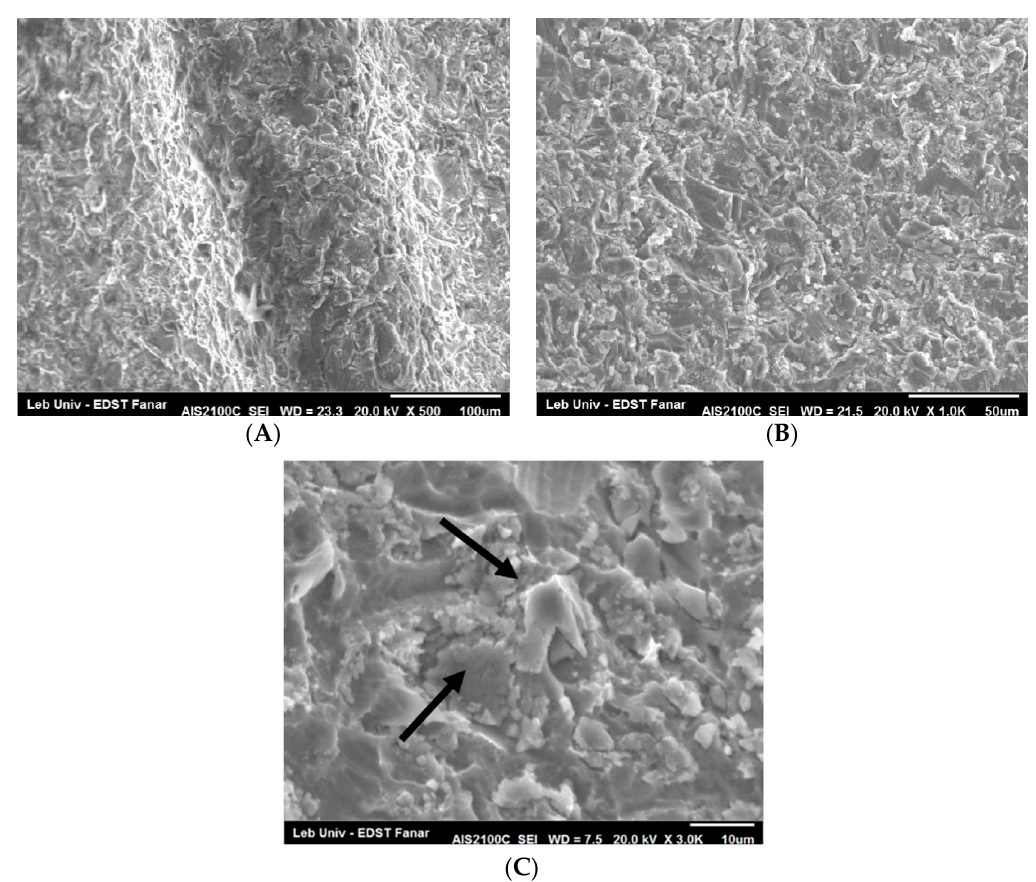
Figure 7. Images illustrating the characteristics of the morphology of the implant surface. Control sterile implant surface, without any conditioning, shows irregular rough surface ( A ) ( × 500), ( B ) ( × 1000), and ( C ) ( × 3000). High-magnification image ( C ) shows ridges and grooves on the implant surface.